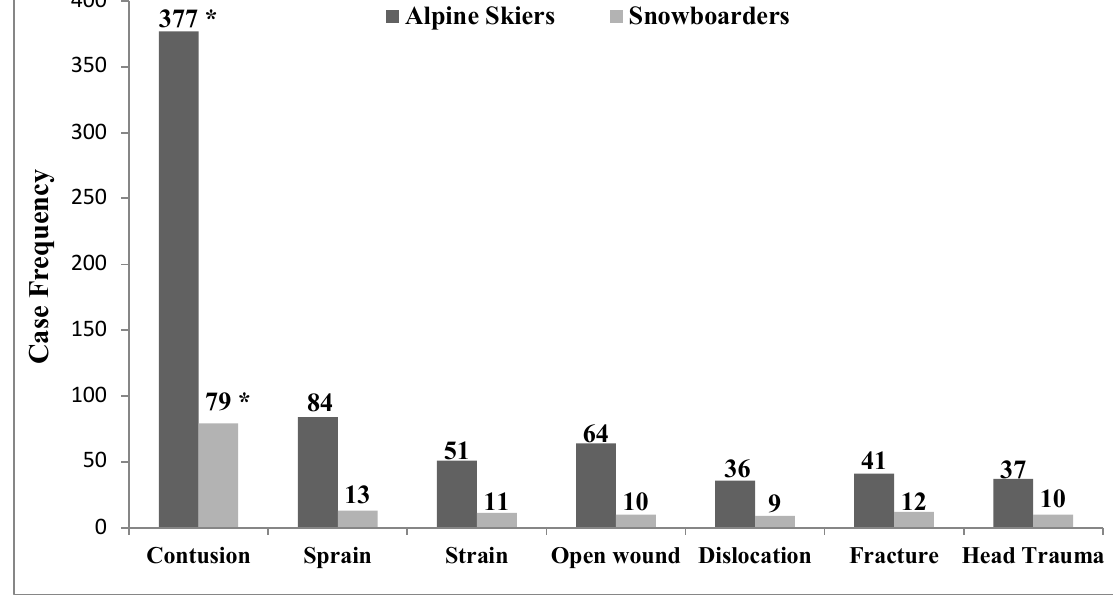
Figure 4. Injury frequency distribution for alpine skiers and snowboarders according to injury